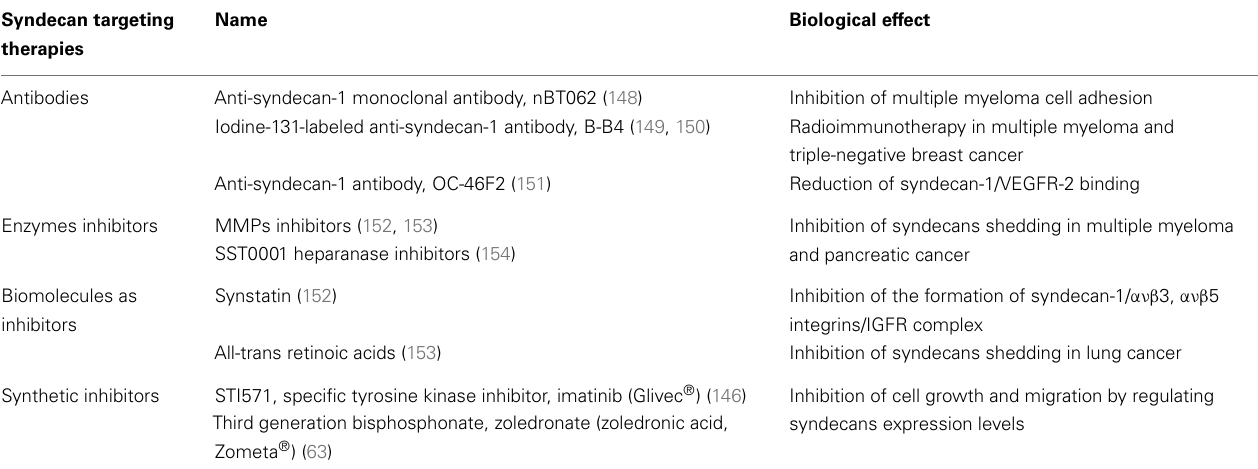
Table 2 | Overview of syndecans (SDCs)-based therapeutic